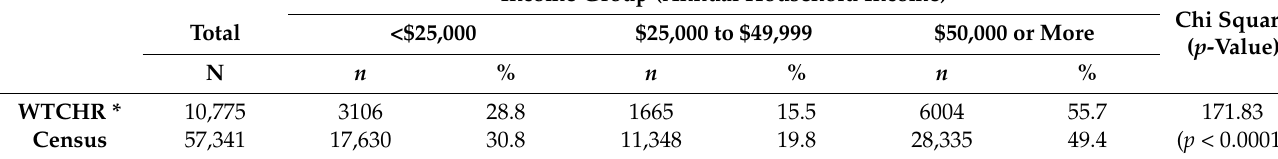
Table 5. Comparison of proportions by annual household income of WTCHR residents on 11 September 2001 with 2000 census for south of Canal Street in Lower Manhattan. Denominator of proportions is Total for all residents.